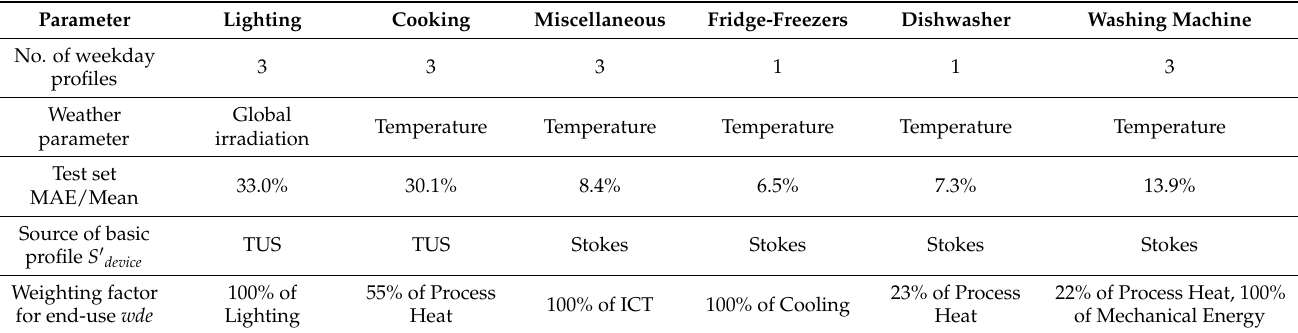
Table 2. Modelling end-uses: The columns contain six devices and the rows show the dependence of the end-use specific power consumption profiles on different types of parameters. MAE, mean absolute error; ICT, information and communications